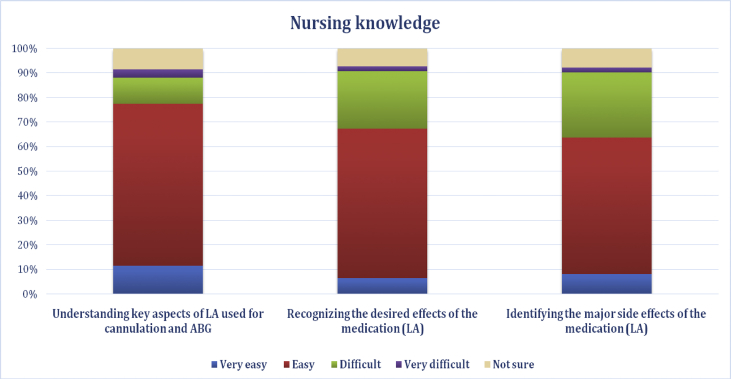
Nursing knowledge.